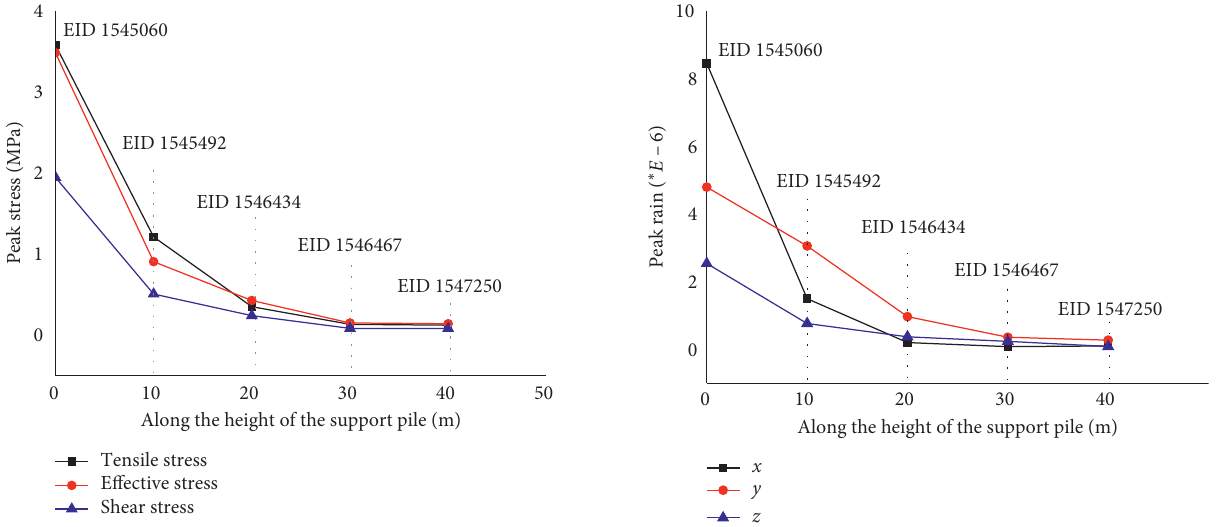
Figure 14: The response trend of the peak strain with the increase in the supporting pile